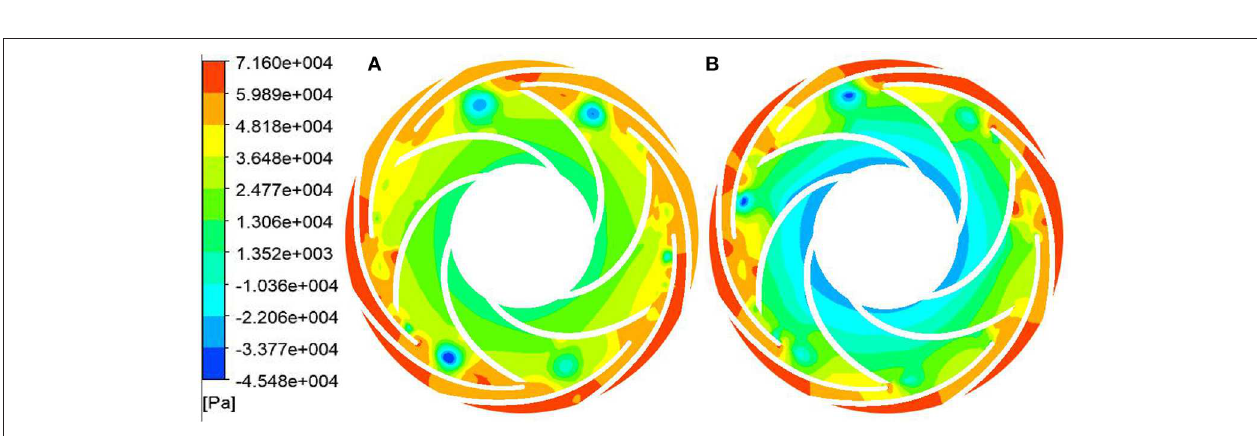
FIGURE 9 | Static pressure distribution of the first stage impeller with n = 600 r/min. (A) Start-up transient of closed-valve and (B) steady state at the same speed.